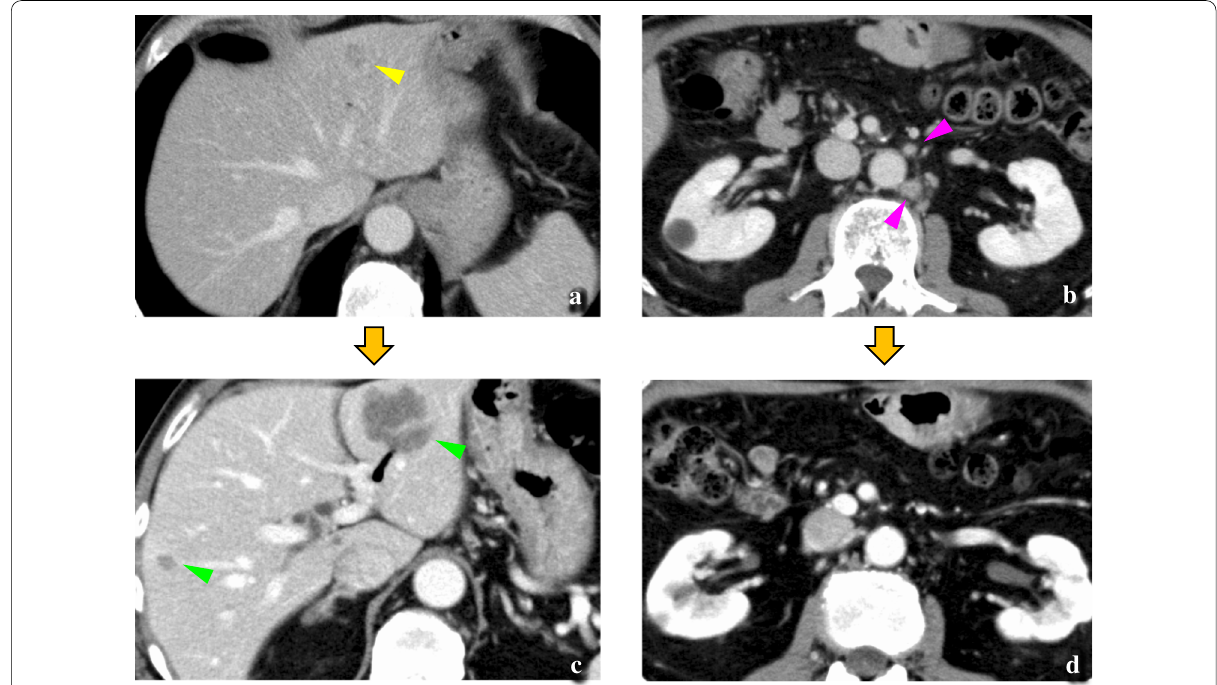
Fig. 1 Computed tomography. Liver metastasis in segment 3 ( a yellow arrowhead) and swollen para-aortic lymph nodes were identified ( b pink arrowheads) 12 months after laparoscopic pancreatoduodenectomy. After six courses of chemotherapy, the liver deposits progressed in segments 3 and 5 ( c green arrowheads), while the lymph nodes regressed ( d